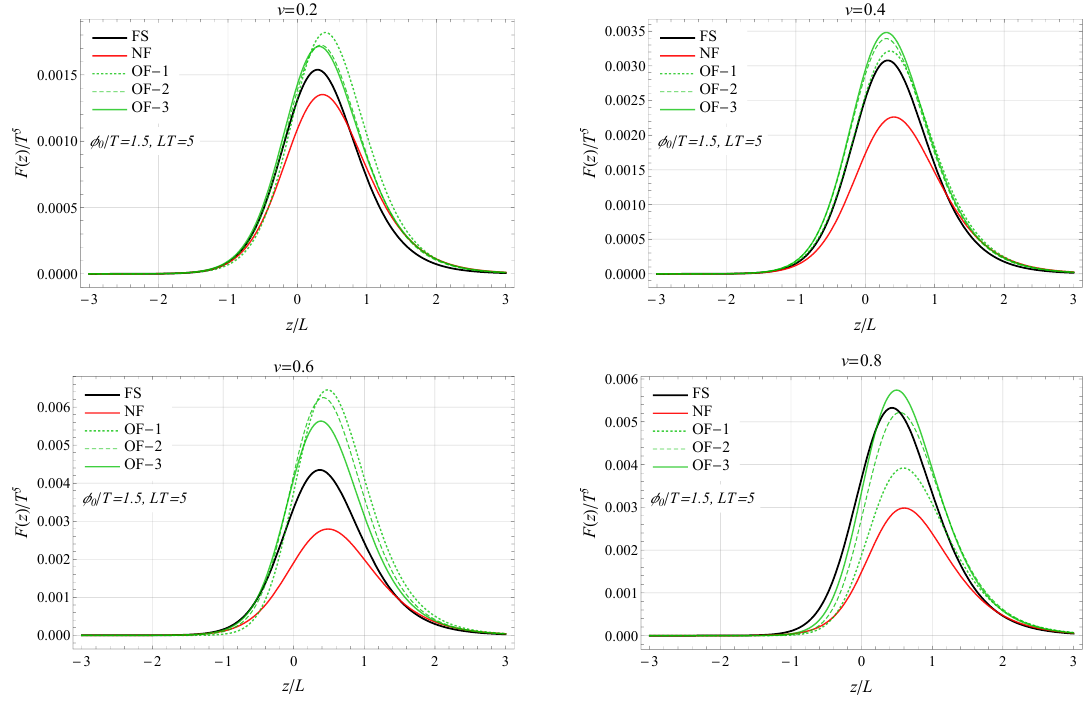
Figure 4 . Friction as a function of the position z when top annihilation and scattering processes are taken into account. The plots correspond to the wall velocities v = 0 . 2 , 0 . 4 , 0 . 6 , 0 . 8